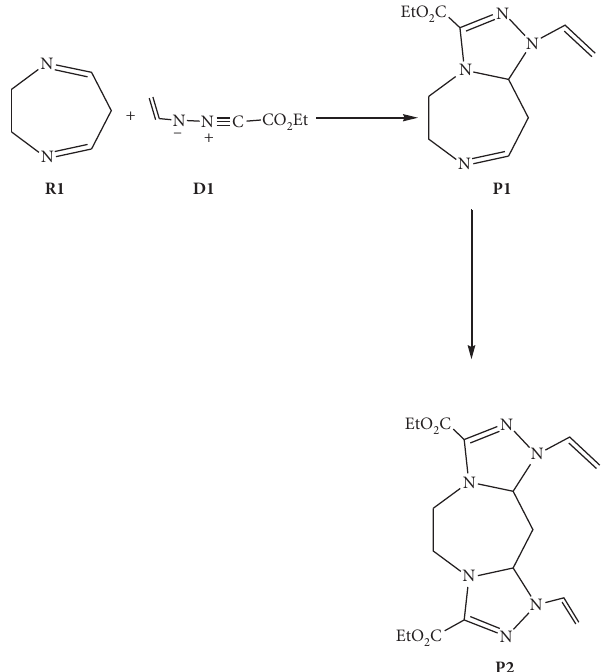
Scheme 2: Reaction of diazepine R1 with nitrilimine